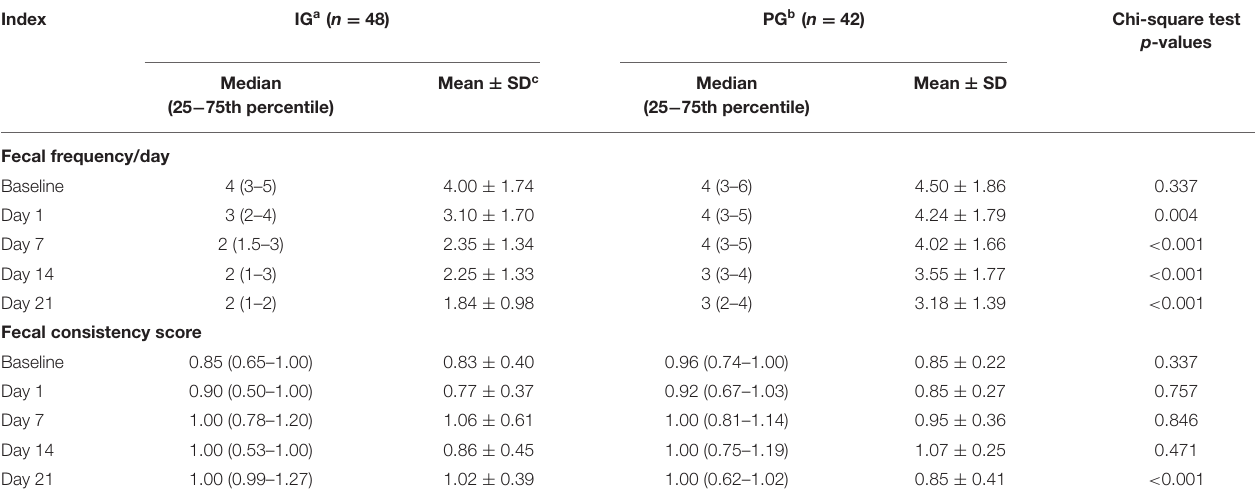
TABLE 3 | Effect of intervention on fecal consistency and frequency.